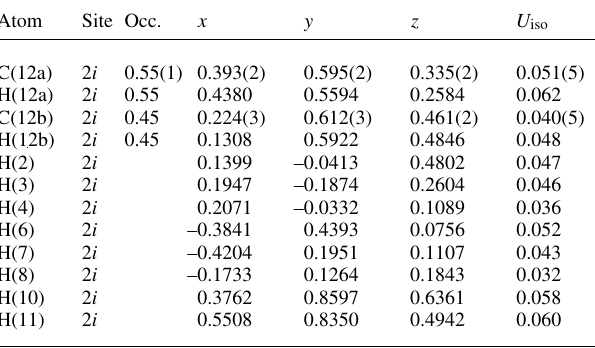
Table 2. Atomic coordinates and displacement parameters (in Å 2 )